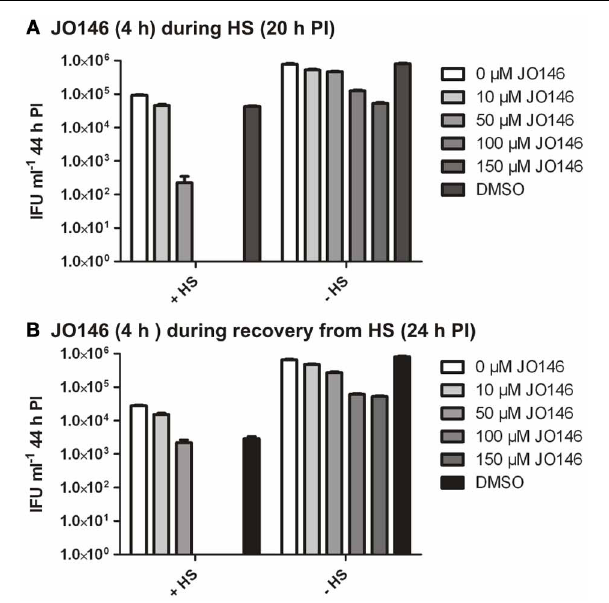
FIGURE 9 | C. trachomatis viable infectious yield at 44h PI after 4h heat shock with JO146 treatment (20–24h PI) or JO146 treatment during recovery from heat shock (24–28h PI). (A) The viable infectious yield after JO146 treatment for 4h at 20h PI with and without heat shock at 42 ◦ C. (B) Viable infectious yield after JO146 treatment for 4h during recovery from heat shock (24–28h PI) ( n = 27). The concentration of JO146 is indicated by the gray scale bars, legend to the right of each